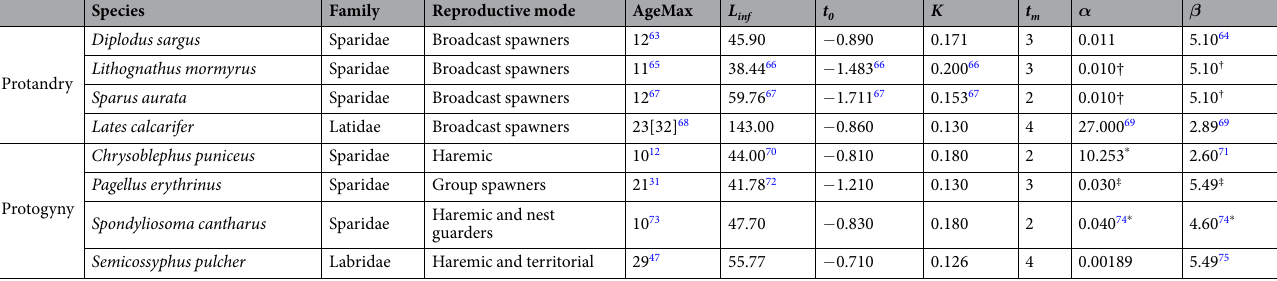
Table 1. Parameters utilized to construct life history tables. AgeMax: maximum age (in years; in square brackets maximum age recorded for few individuals, not used in the model); L inf : asymptotic length (in cm); K : growth coefficient; t 0 : theoretical age at length = 0; t m : age at first maturity; α : constant in the fecundity relationship (adjusted to standard length); β : exponent in the fecundity relationship. Values are obtained from FishBase 49 unless specified. * Values calculated from available data for Spondyliosoma cantharus 74 ; † data obtained for D. sargus ; ‡ extrapolated values from fecundity.